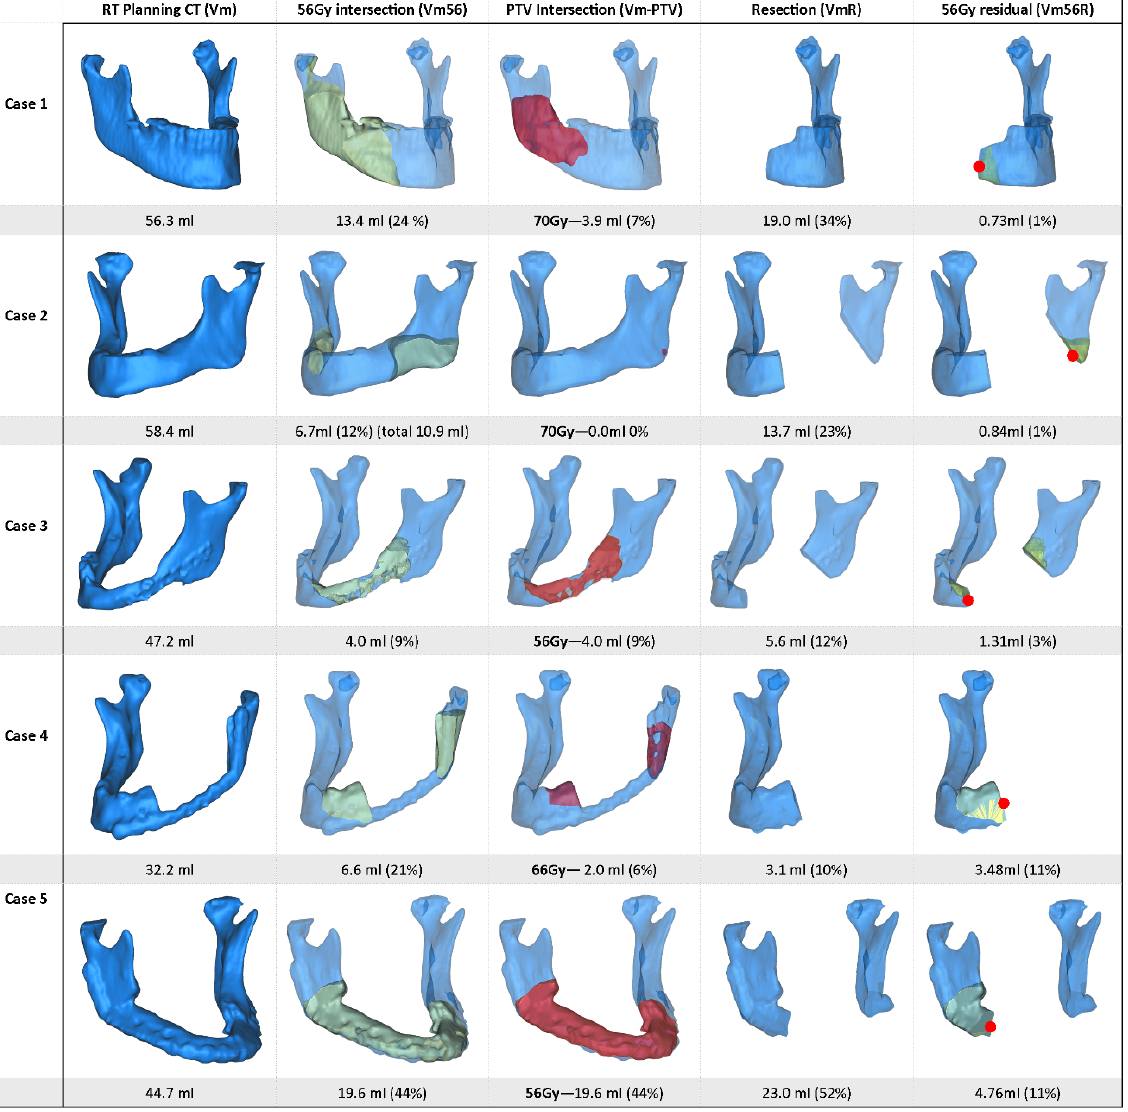
Figure 3. Overview of patients with recurrence of ORN after segmental resection. The first column illustrates the 3D segmentation of the mandible during radiotherapy, representing the total mandibular volume (Vm). The second column illustrates, in yellow, the volume of the mandible inside the 56Gy isodose (Vm56). The third column, in red, represents the volume of the mandible inside the PTV (Vm-PTV). The forth column shows the postoperative situation after segmental resection (VmR). The last column shows the residual volume of Vm56 after resection surgery (Vm56R). The red dots in the last column indicate the location of the ORN recurrence.